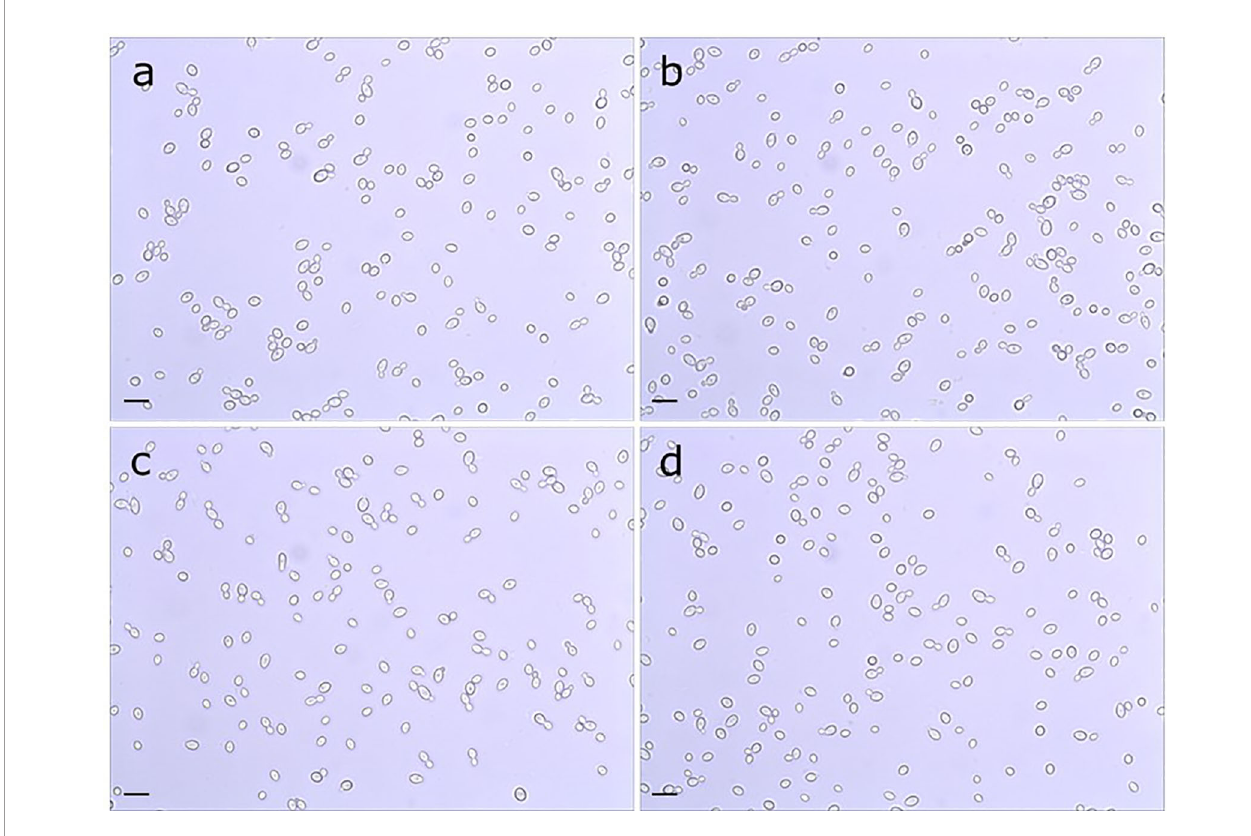
FIGURE 1 | Light micrograph of C. albicans cells from parent strain (A) SC5314, (B) D pir1-1 / D pir1-2 strain 3097, (C) D pir32-1 / D pir32-2 strain 3545 and (D) D pir1-1 / D pir1-2 D pir32-1 / D pir32-2 strain 3543. Cultures were grown for 16 h in PDB at 37°C and 200 rpm shaking. All strains grew as budding yeast with minimal presence of elongated/irregular forms or aggregation. The scale bar in the lower left of each image = 10 m